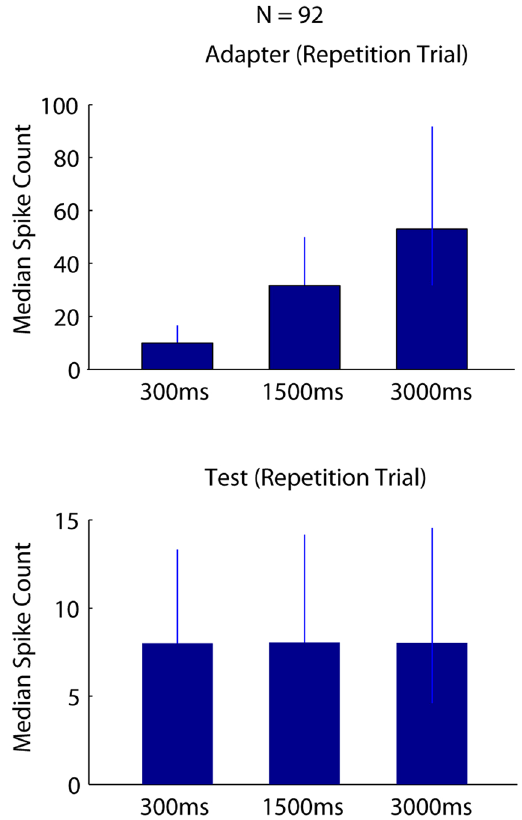
Figure 6. Integrated spike counts of single IT units during adapter and test presentations for different adapter duration conditions compared. ( A ) Median (and quartiles) spike counts integrated across the whole adapter presentation for 300, 1500 and 3000 ms adapter durations. ( B ) Median spike counts during the whole 300 ms long test presentation following the 300, 1500 and 3000 ms long adapter. Data from repetition trials